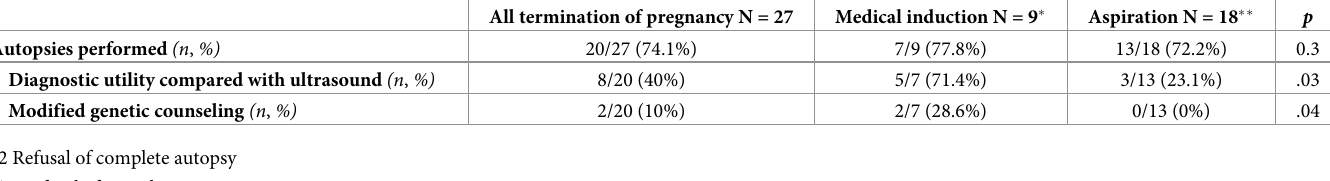
Table 5. Value of fetal autopsy globally and by method of termination for cerebral